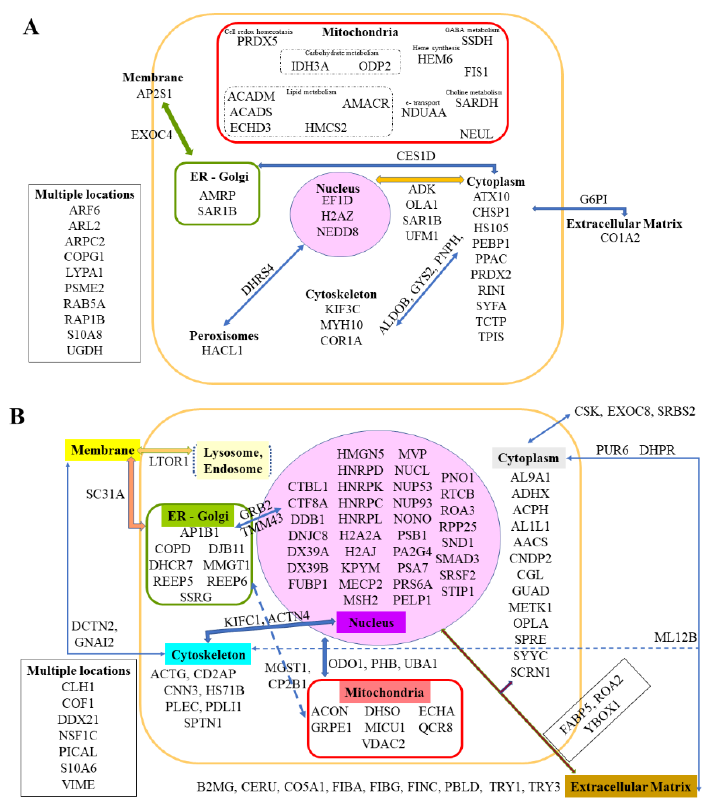
Figure 4. Additional biomarkers of interest showing abundance changes under metastatic colonization. ( A ) Liver biomarkers exhibiting significant decreased abundance in G2 vs. G1 and G3 vs. G2 but not in G3 vs. G1. ( B ) Liver biomarkers exhibiting significant increased abundance in G2 vs. G1 and G3 vs. G2 but not in G3 vs. G1. Each protein of interest is represented by its abbreviation and location (according to Uniprot.org). For proteins located in several subcellular compartments or extracellular matrixes, links between these are represented by arrows. The full names and equivalent human genes that encode the corresponding proteins are provided in Tables S1 and S2. Cancers 2020 , 12 , x